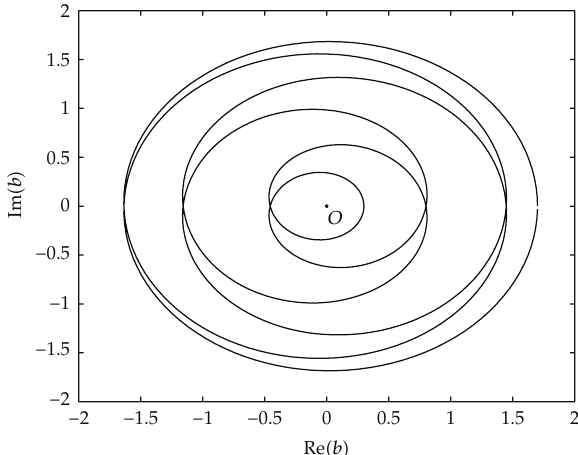
Figure 2: D -decomposition of the complex plane of the parameter b for k (cid:3) 6, a (cid:3) 0 . 7.